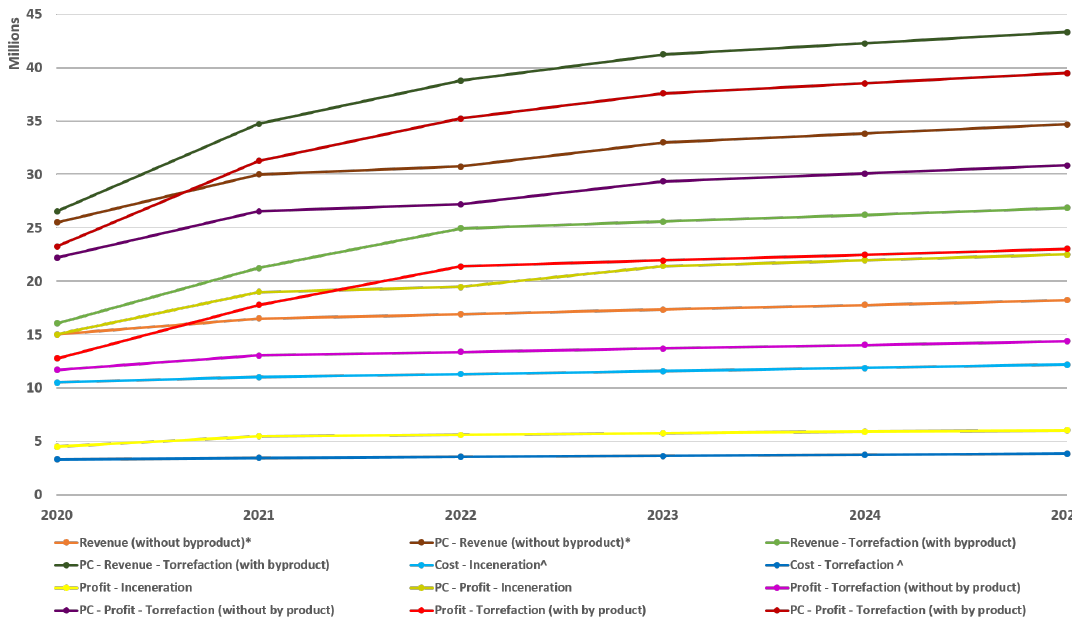
Figure 4. Comparison of revenue, cost and profit for incineration and torrefaction processes of waste processing in Polish municipalities from 2020 to 2025, for 30,000 mg/a municipal waste (data source: EkoPartner). * The revenue from waste collection is the same for both torrefaction and incineration, ∧ Cost of processing the was remained same before and after the pandemic, (PC)—Post COVID-19